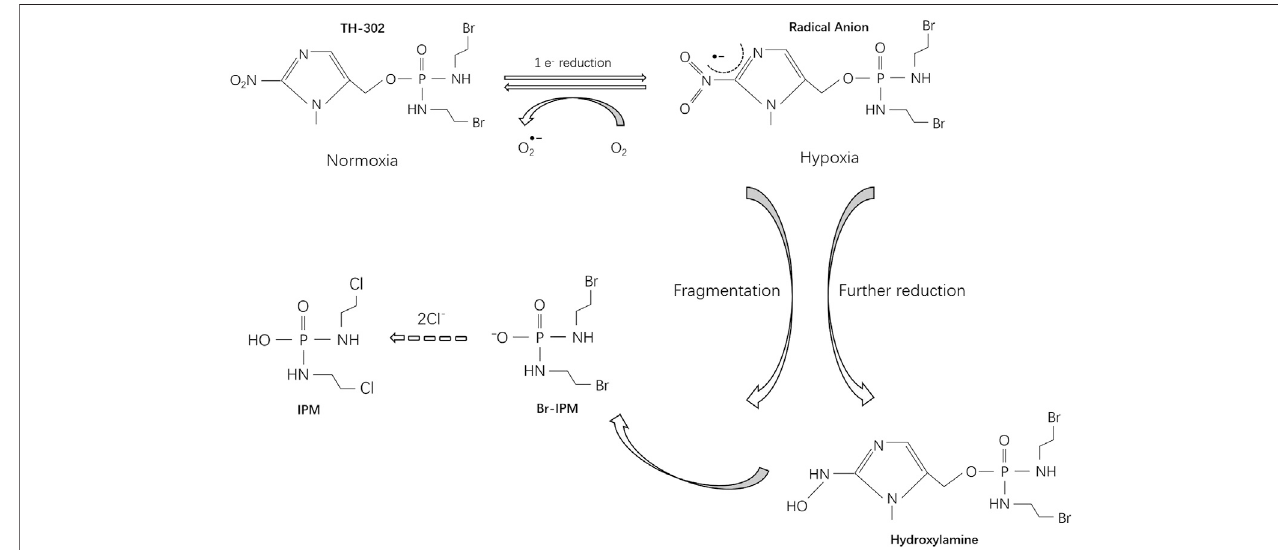
FIGURE 1 | Metabolism of